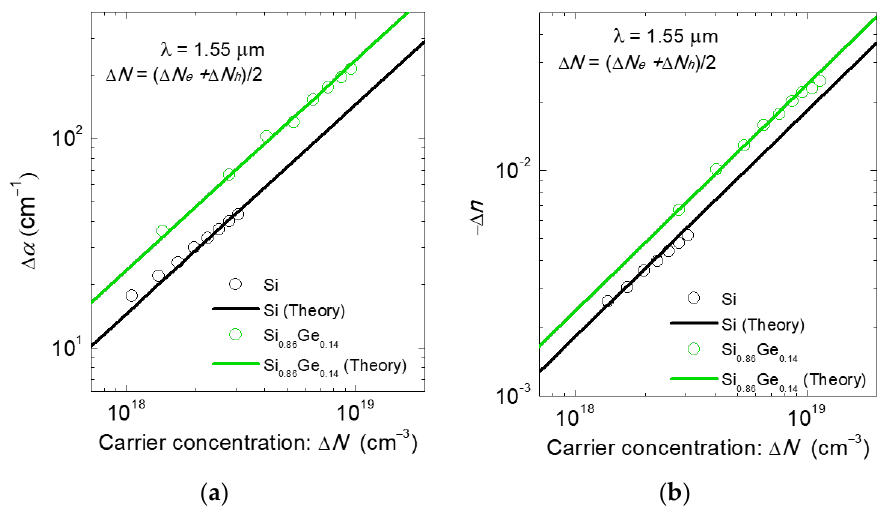
Figure 2. Changes in optical constants of Si 0.86 Ge 0.14 and Si as functions of carrier concentration. ( a ) Change in refractive index and ( b ) Change in absorption coefficient [53].